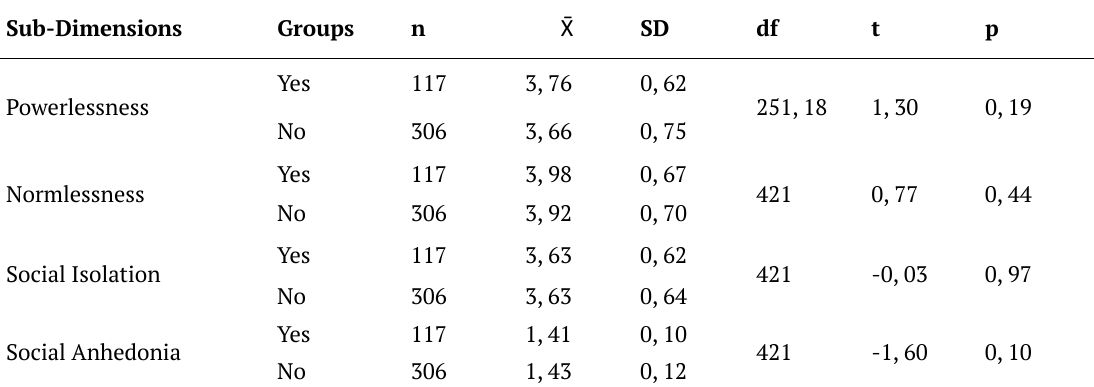
Table 6. Differences between the sub-dimensions of RSAS and DAS according to the status of students catching the Corona virus Sub-Dimensions